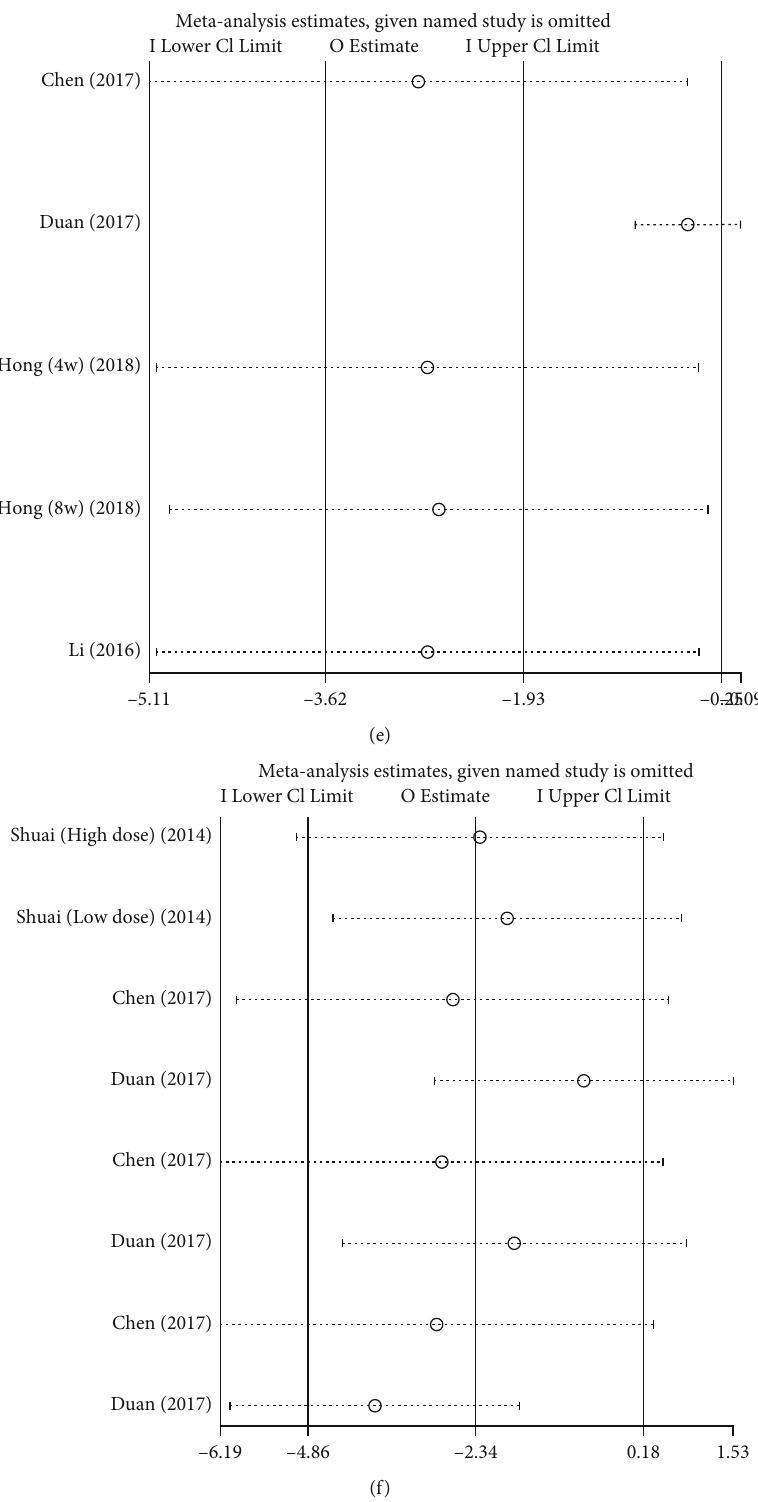
Figure 10: Sensitivity analysis of this meta-analysis. BMSCs vs. OVX control: (a) BMD, (b) BV/TV, and (c) Tb.N, Tb.Th, and Tb.Sp; BMSCs vs. sham control: (d) BMD, (e) BV/TV, (f) Tb.N, Tb.Th, and